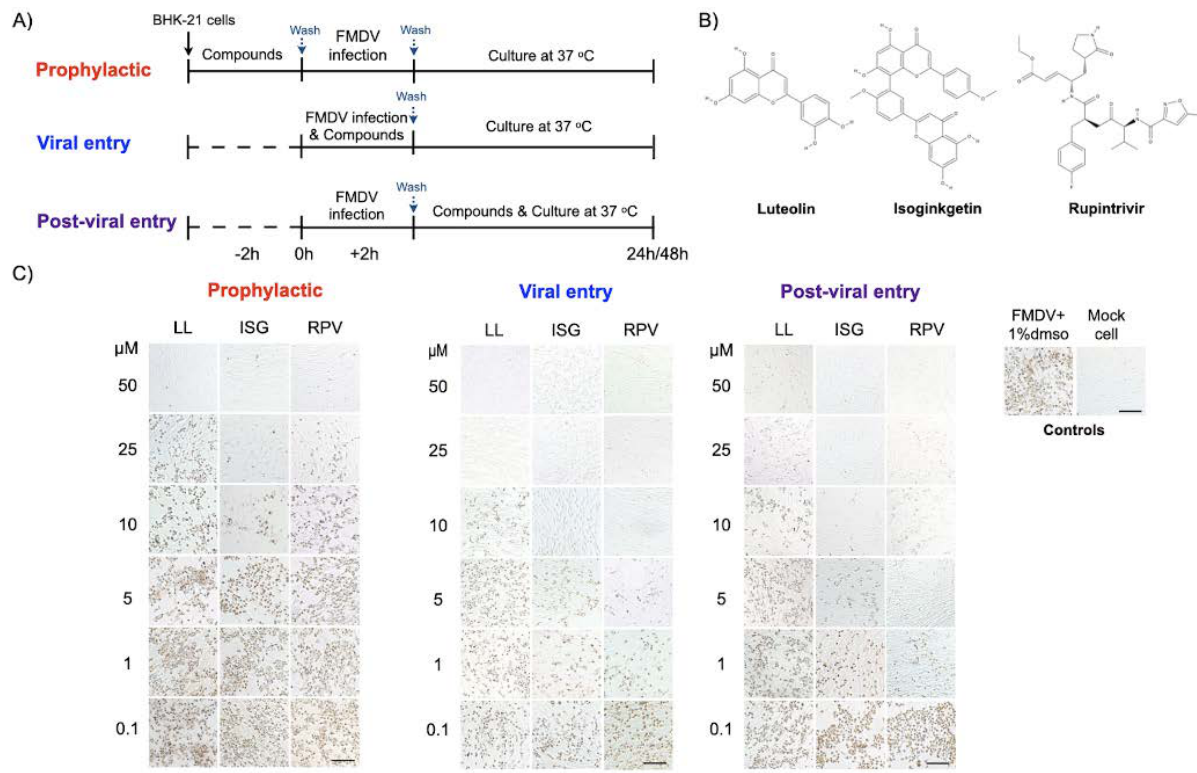
Figure 1. Antiviral activity of luteolin and isoginkgetin against FMDV in the cell-based assay. The compounds were treated at different times of FMDV infection, which were the prophylaxis (–2 h), viral entry (0 h), and post-viral entry (+2 h) experiments ( A ). The FMDV- and mock-infected BHK-21 cells in culture media with 1% DMSO were included as positive and negative virus controls, respectively (A, right panel). The 2-D structure of luteolin, isoginkgetin, and rupintrivir ( B ). The dose-dependent response was evaluated from the numbers of positive FMDV-infected cells using IPMA. Intensity and quantity of the dark brown cells directly reflects numbers of viral infected cells. The EC50 values were calculated using CellProfiler image analysis ( C ). LL (luteolin), ISG (isoginkgetin), and RPV (rupintrivir). The scale bar was 200 µ